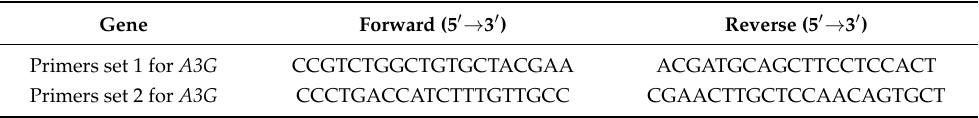
Table A2. Primers for